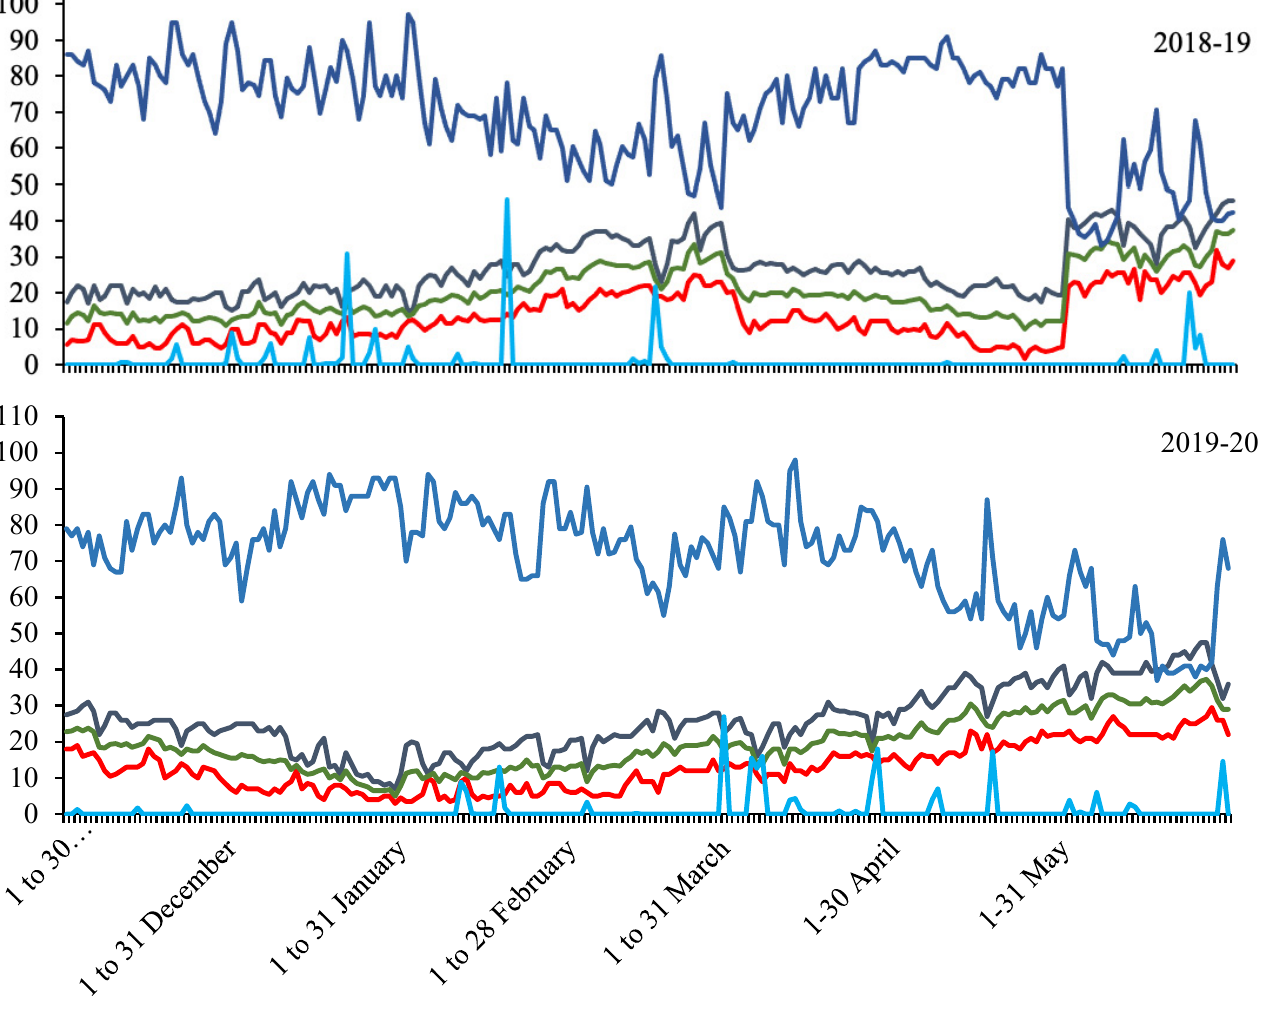
Figure 1. The weather data of experimental station throughout the course of experimentation.